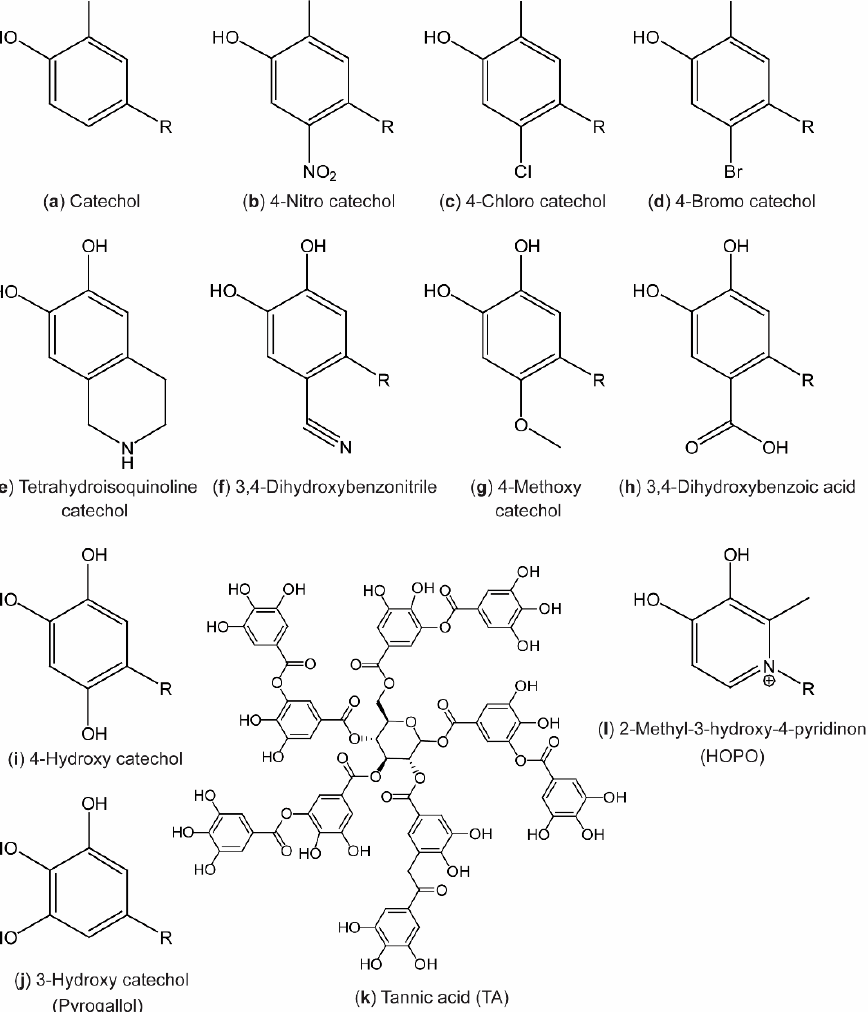
Figure 2. Catechol analogues reported in the literature. The molecules have been named according to the International Union of Pure and Applied Chemistry (IUPAC) order of precedence, assuming that the R group (representing the remainder of the molecule) has lower priority than the catechol hydroxyl groups.